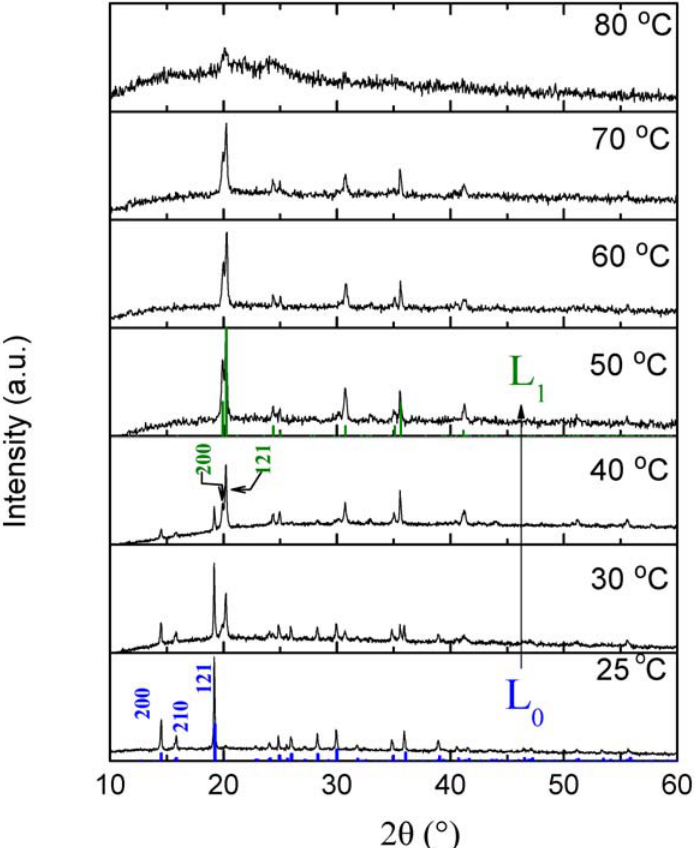
Figure 5. Sequence of X-ray powder diffraction patterns of as-prepared Co(H O) [Ni(CN) ]·4H O (L phase) from room temperature to 80 °C, showing the 2 2 4 2 0 transition to the L phase upon dehydration and its further collapse into an amorphous 1 material. Colored bar-plots correspond to diffraction lines expected for each of the pure (blue) and L phases: L 0 1